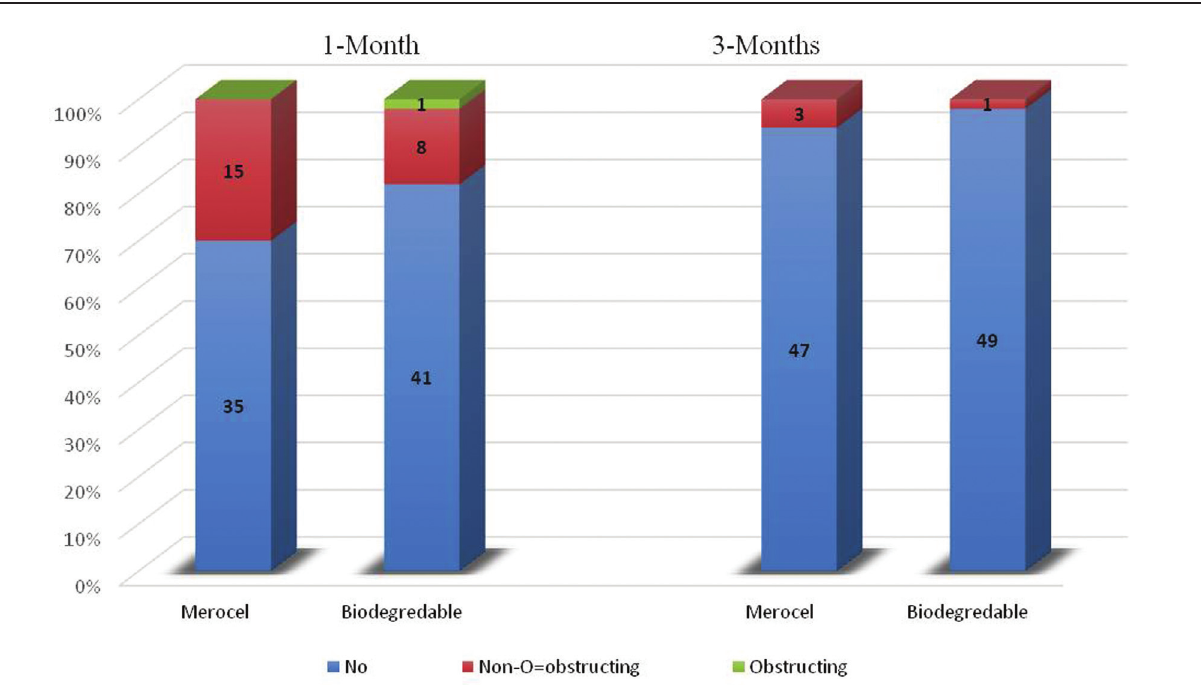
Bar chart illustrating synechia formation at 1- and 3-month postoperatively.